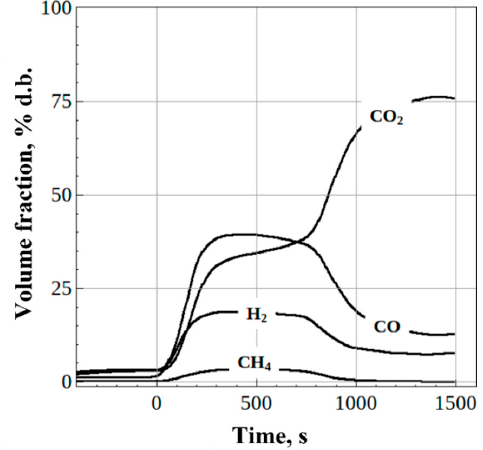
Figure 12. Measured time histories of the cooled dry syngas composition obtained by gasification of solid organic waste (sawdust) at (cid:1858) = 1 Hz and (cid:1842) (cid:3406) 0.1